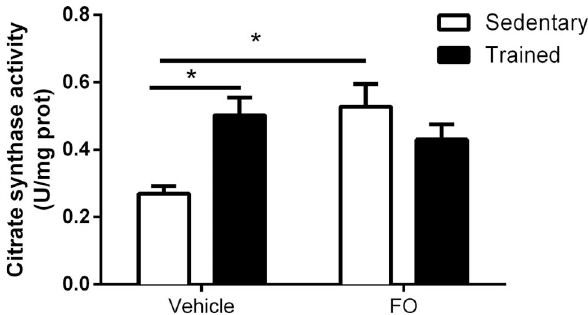
Figure 3 - Oxidative metabolic marker in the heart from juvenile rats. All data are presented as mean ± SEM. These rats were previously sub- divided into exercised and sedentary groups, and they received one single daily dose of fish oil or vehicle solution (for 4 weeks). *p < 0.05 in a Two-way ANOVA test followed by the